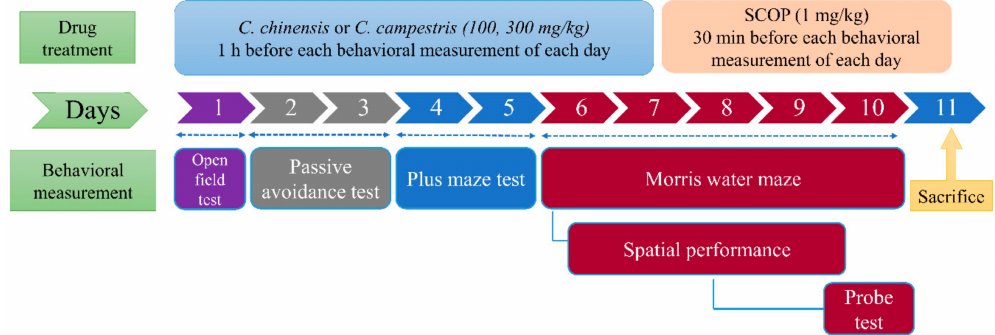
Figure 10. The schedule of drug treatments and behavioral measurements. The Cuscuta chinensis or C. campestris extract (100 and 300 mg/kg, po) was administered 1 h before each behavioral assessment of each day during the experimental period. Scopolamine (SCOP, 1 mg/kg, ip) was administered 1 h before each behavioral assessment of each day during the experimental period. C. chinensis : Cuscuta chinensis ; C. campestris : Cuscuta campestris